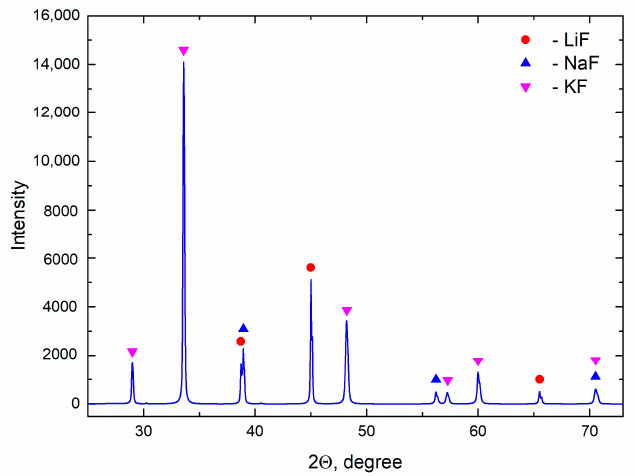
Figure 2. The X-ray diffraction pattern of prepared FLiNaK.